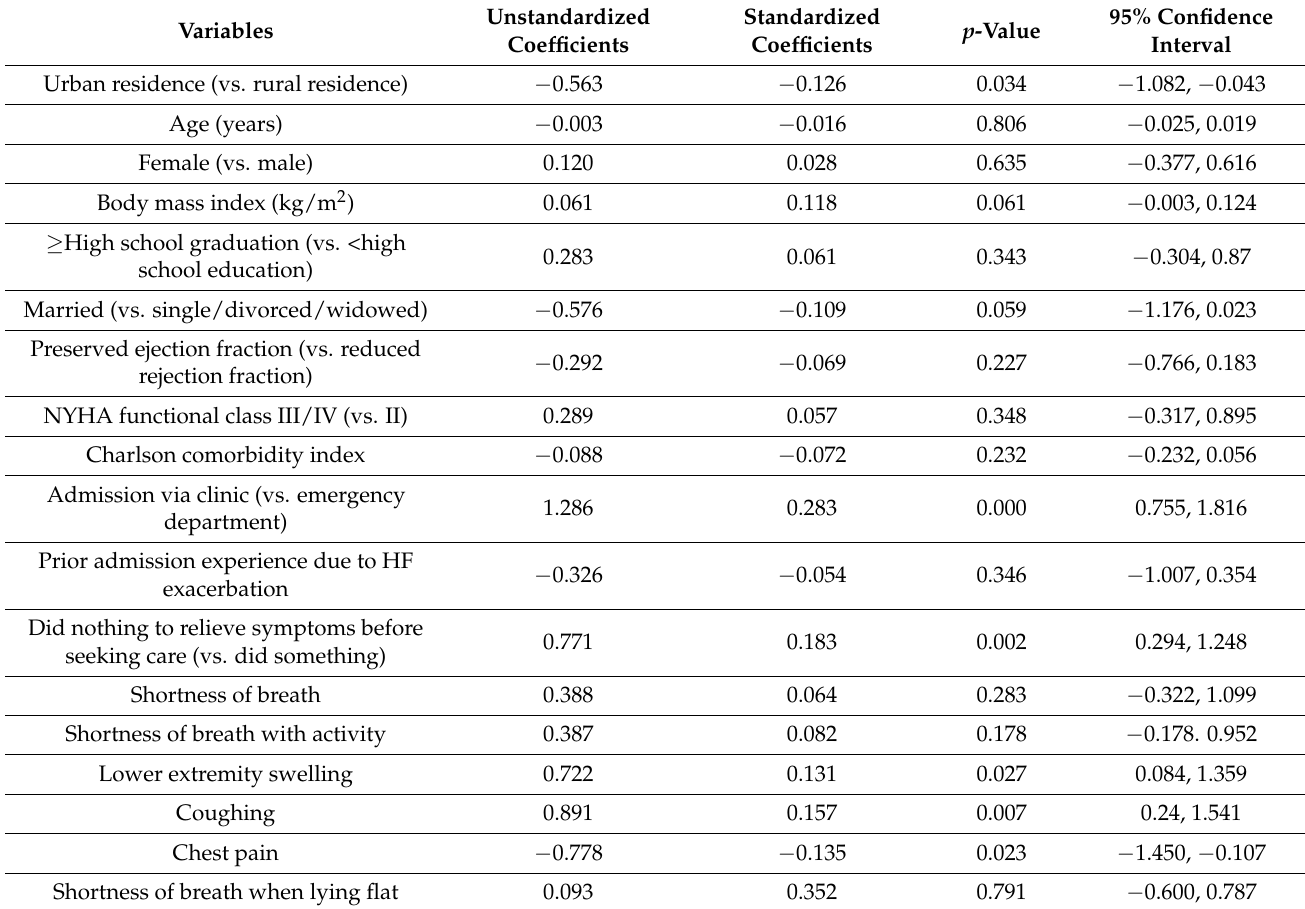
Table 3. Factors associated with pre-hospital delay in seeking medical care (N =